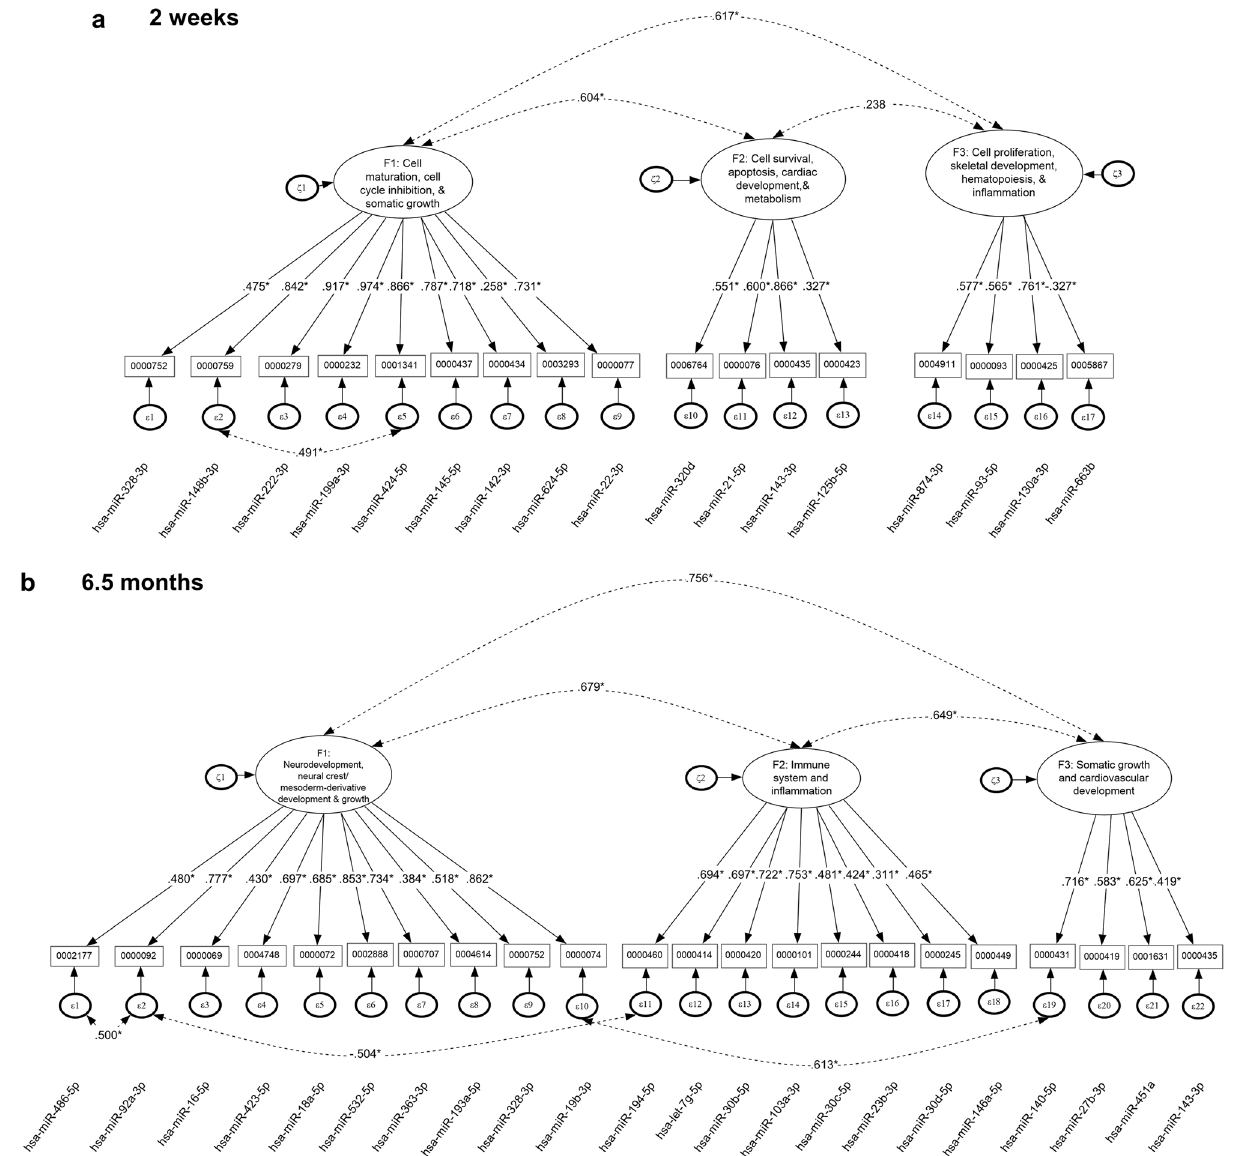
Figure 6. Confirmatory factor analysis clustered PAE-sensitive ex miRNAs into factors associated with distinct developmental pathways. Structural equation modeling of ex miRNA loading into the 3-factor solutions at ( a ) T 2wk and ( b ) T 6.5mo . Factors are named based on IPA analysis of the canonical pathways and disease and biofunctions for the mRNAs targeted by the miRNAs within each factor (see Supplementary Fig. 6, 8). Figures were constructed using Inspiration (version